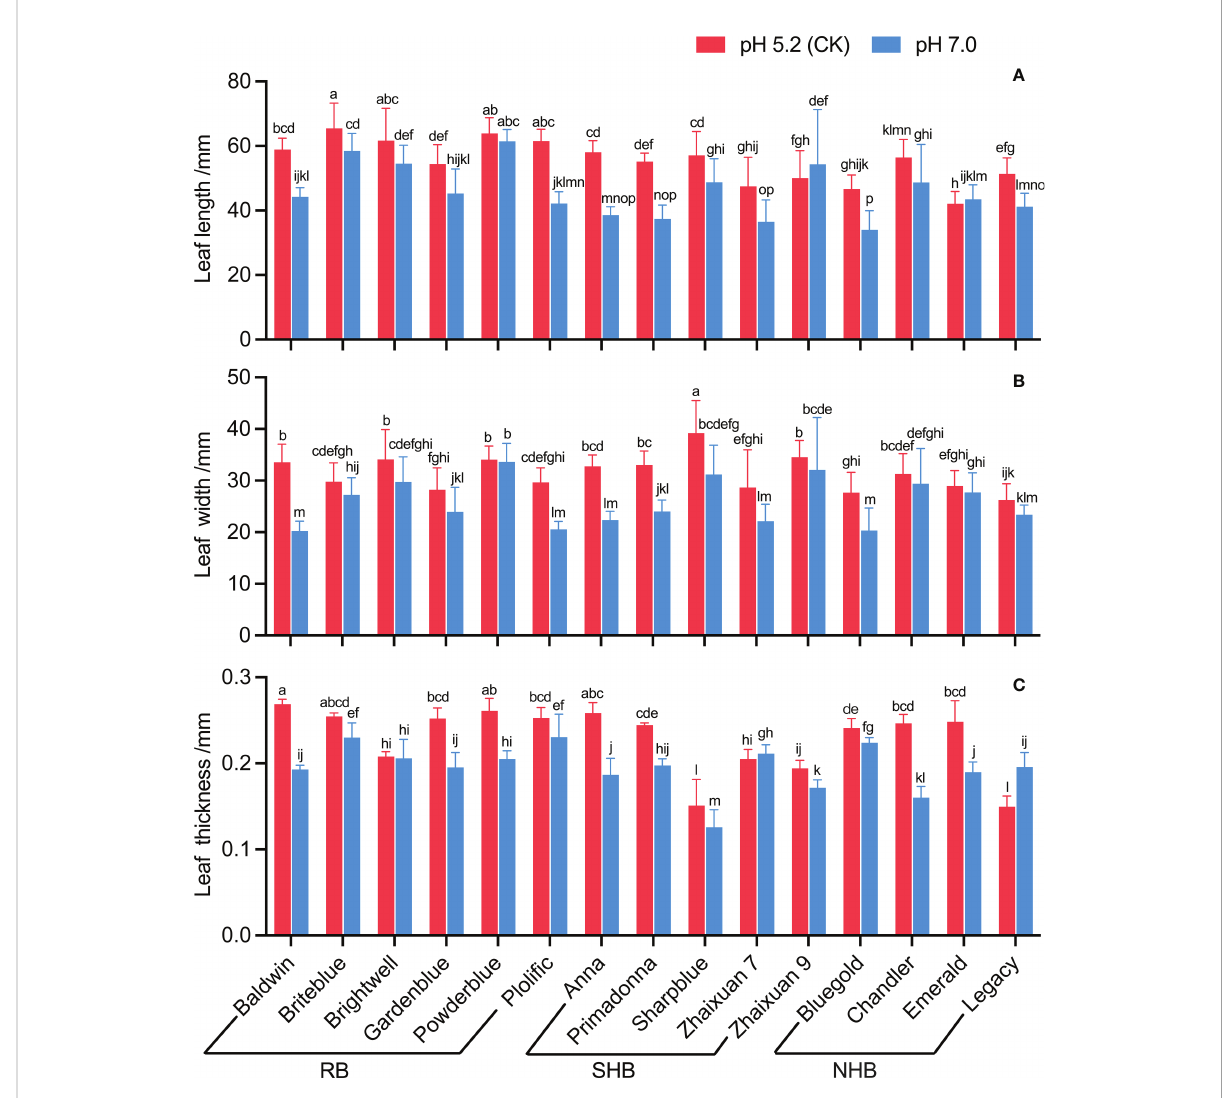
FIGURE 3 Effects of high soil pH stress on the leaf traits of 15 blueberry seedling cultivars. The leaf length (A) , leaf width (B) , and leaf thickness (C) . Columns with different letters signi fi cantly (p < 0.05) differed based on Duncan ’ s multiple range